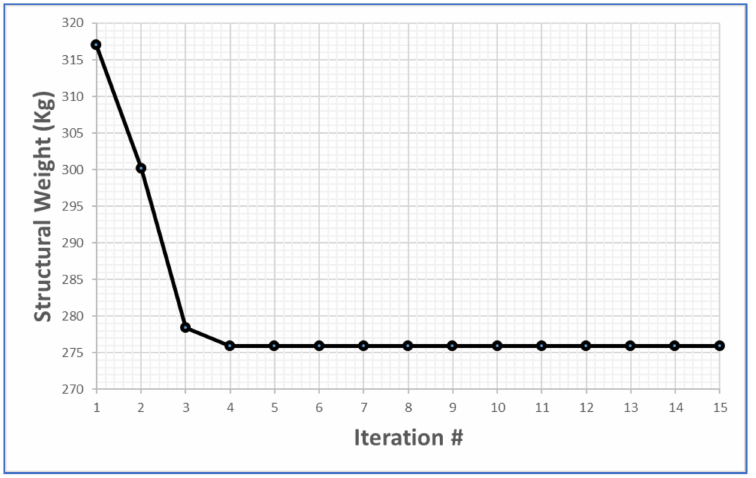
Figure 15. Iteration history for particle swarm optimization.